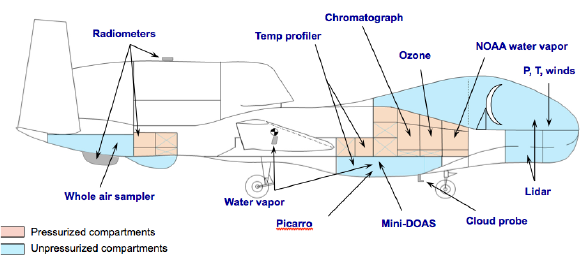
Figure 12. Global Hawk payload diagram for